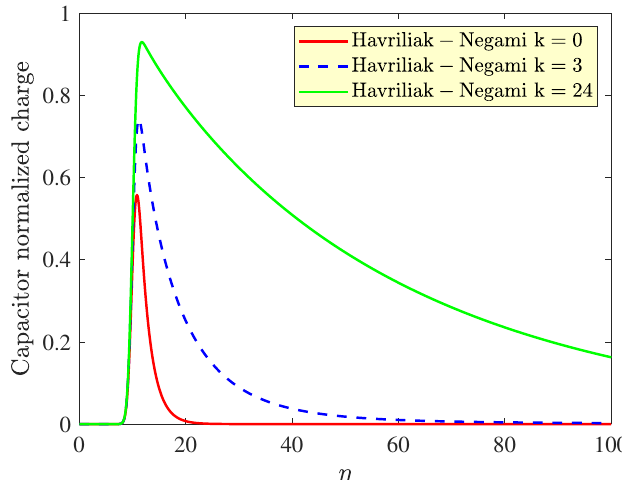
Figure 17. Solution with τ = 153, α = 0.4, β = 0.1 and different values of κ